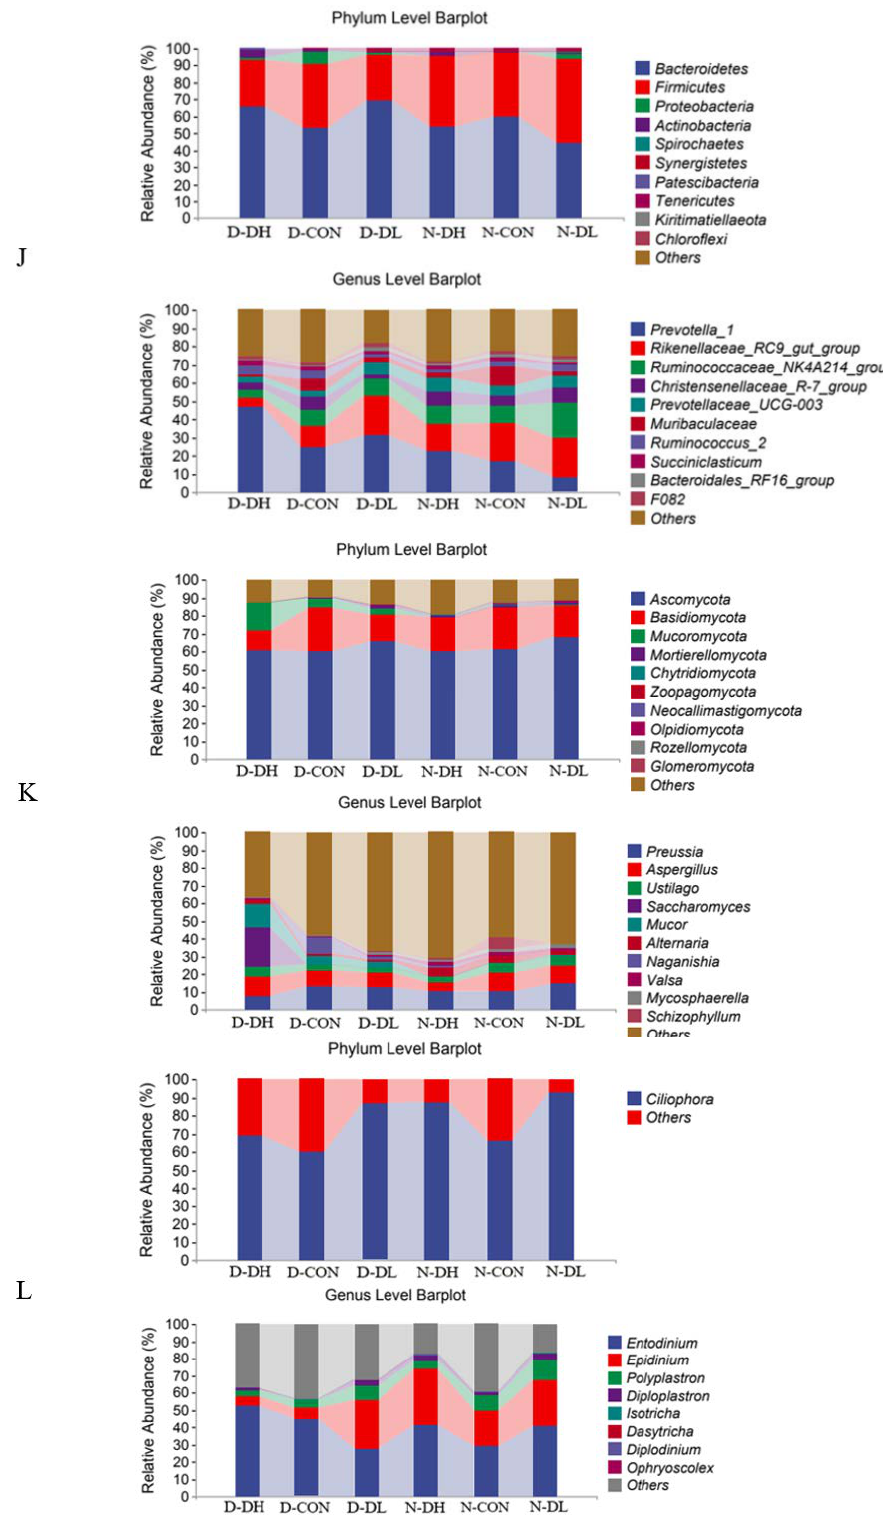
Figure 4. Composition of rumen microflora at phylum and genus level in mutton sheep fed with different diets. In the figure, the abscissa in the figure is the name of each sample/group/whole of the grouping scheme, and the ordinate is the relative abundance of each taxon at a specific classification level. ( J ) represents bacteria, ( K ) represents fungi, and ( L ) represents protozoa; D represents 12 h of the day, and N represents 12 h at night.